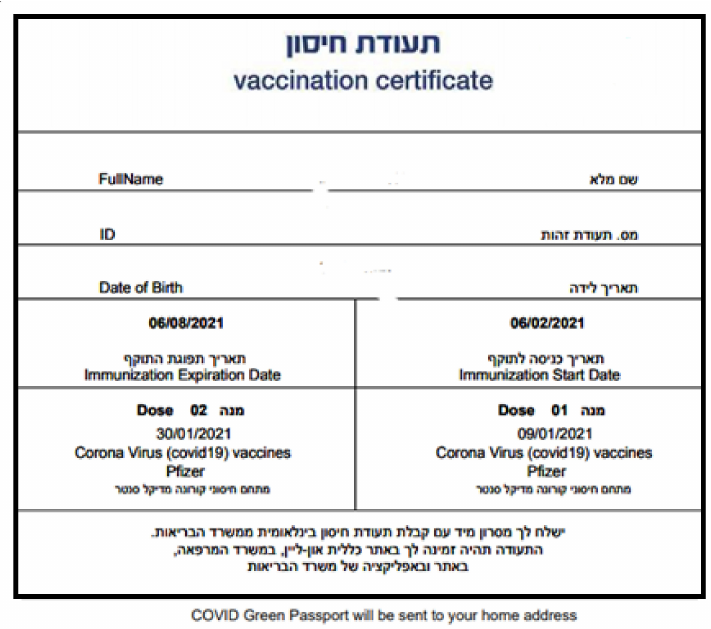
Figure 2. Example of a Vaccination